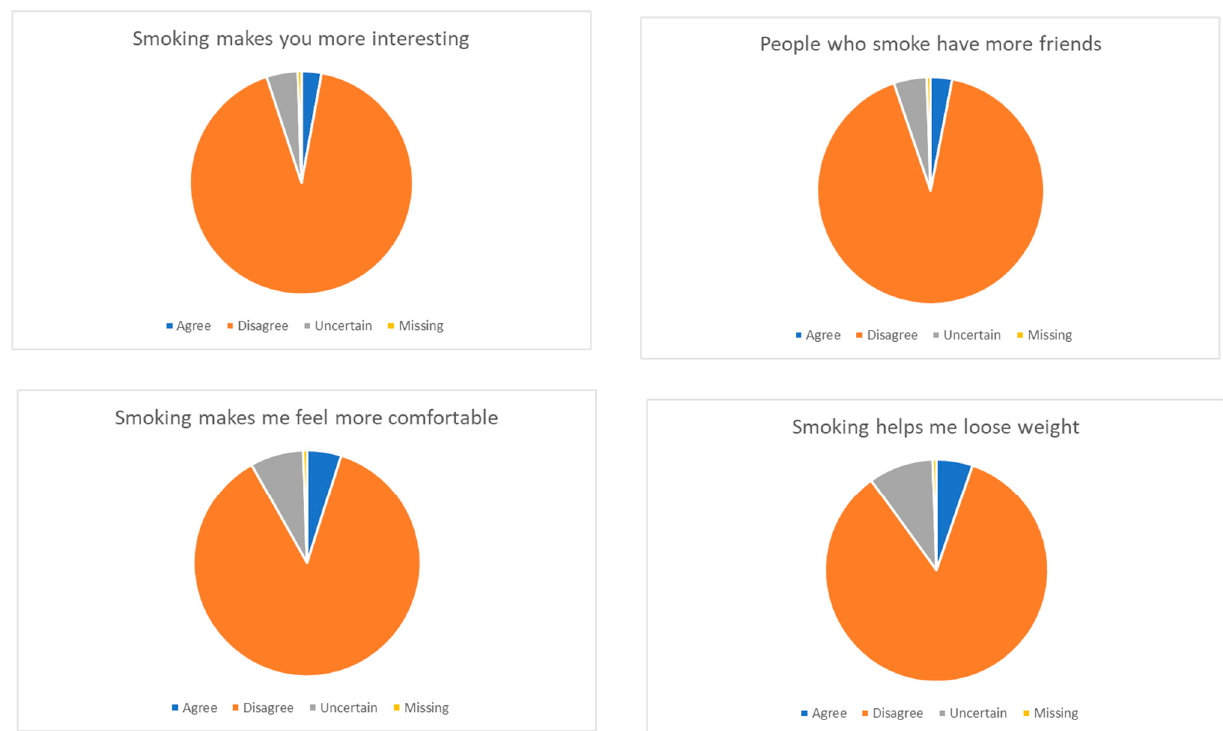
Figure 2. Attitudes and social perceptions toward smoking habits.